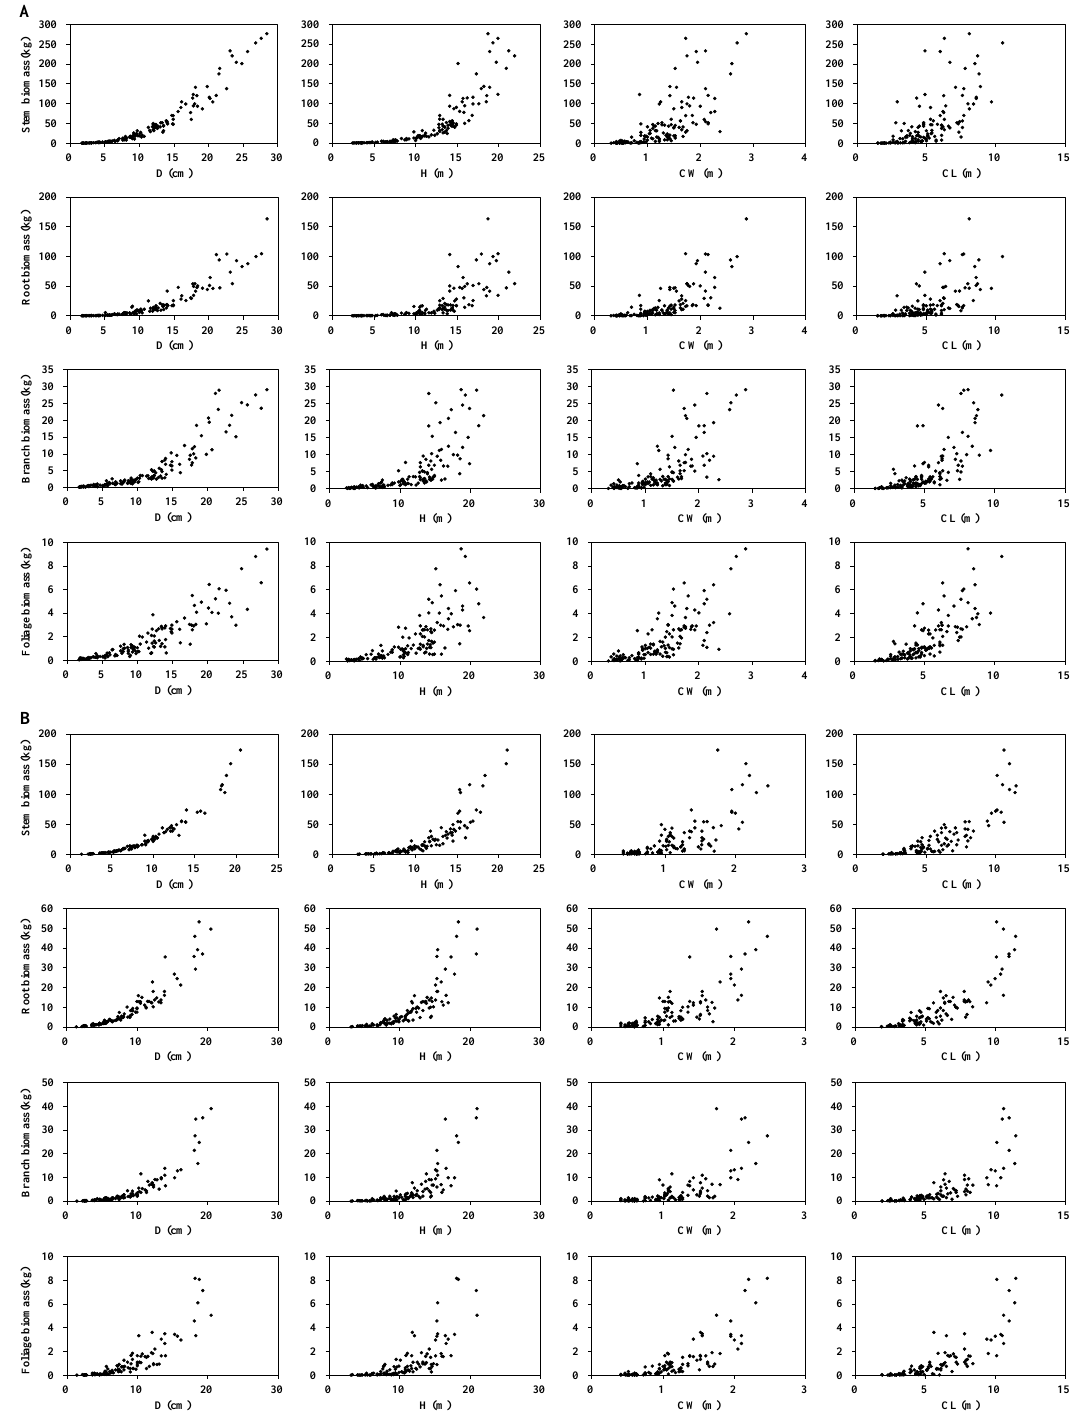
Figure 2. Relationships between stem, root, branch, and foliage biomass and diameter at breast height (D), tree height (H), crown width (CW), and crown length (CL), respectively, for ( A ) Dahurian larch and ( B ) white birch.